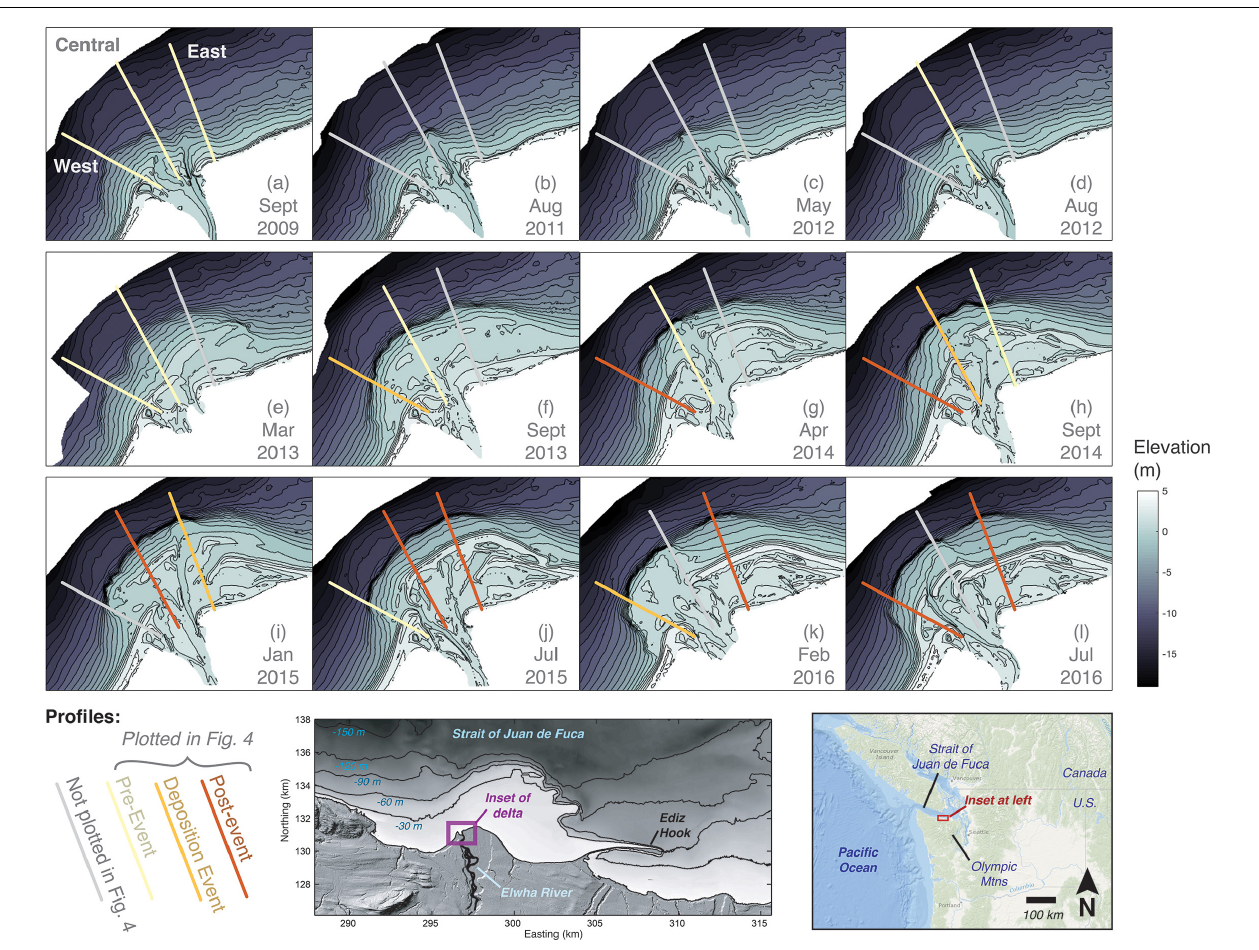
FIGURE 2 | (a–l) Topographic and bathymetric data of the Elwha River mouth of Washington (48.148 ◦ N, 123.567 ◦ W) collected between 2009 and 2016 that were used for analyses. These data were collected before and after a dam removal project that caused ∼ 5 million cubic meters of deposition in and around the delta. Three cross-shore profiles (West, Central and East) were chosen for morphodynamic analyses. These profiles were defined as perpendicular to offshore bathymetry and bisecting the new lobes of sediment. The location of the new sediment lobes changed with time as the river course changed. Profiles are coded with colors according to the presentation in Figure 4